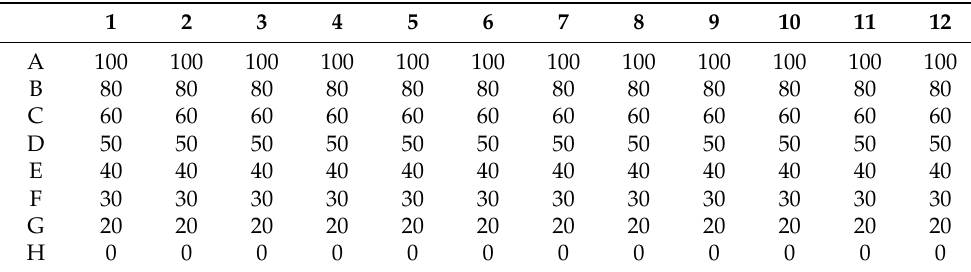
Table 1. DCB-230 concentrations ( µ g/mL) and the plate layout in 96